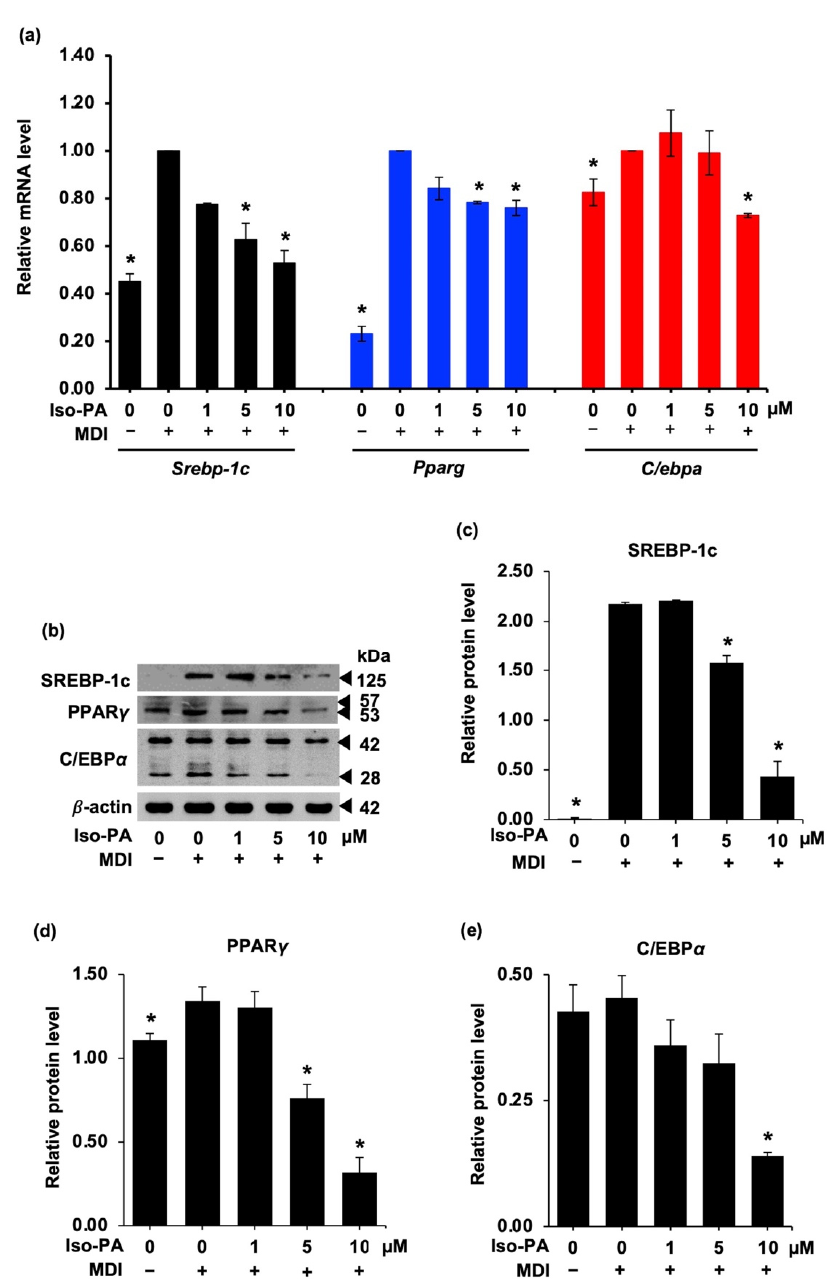
the SREBP-1C, PPAR γ , and C/EBP α proteins in the differentiated 3T3-L1 cells cultured with 5–10 μ M of isopanduratin A, compared to differentiated control groups (Figure 5b– d). with 5–10 µ M of isopanduratin A, compared to differentiated control groups (Figure 5b–d).